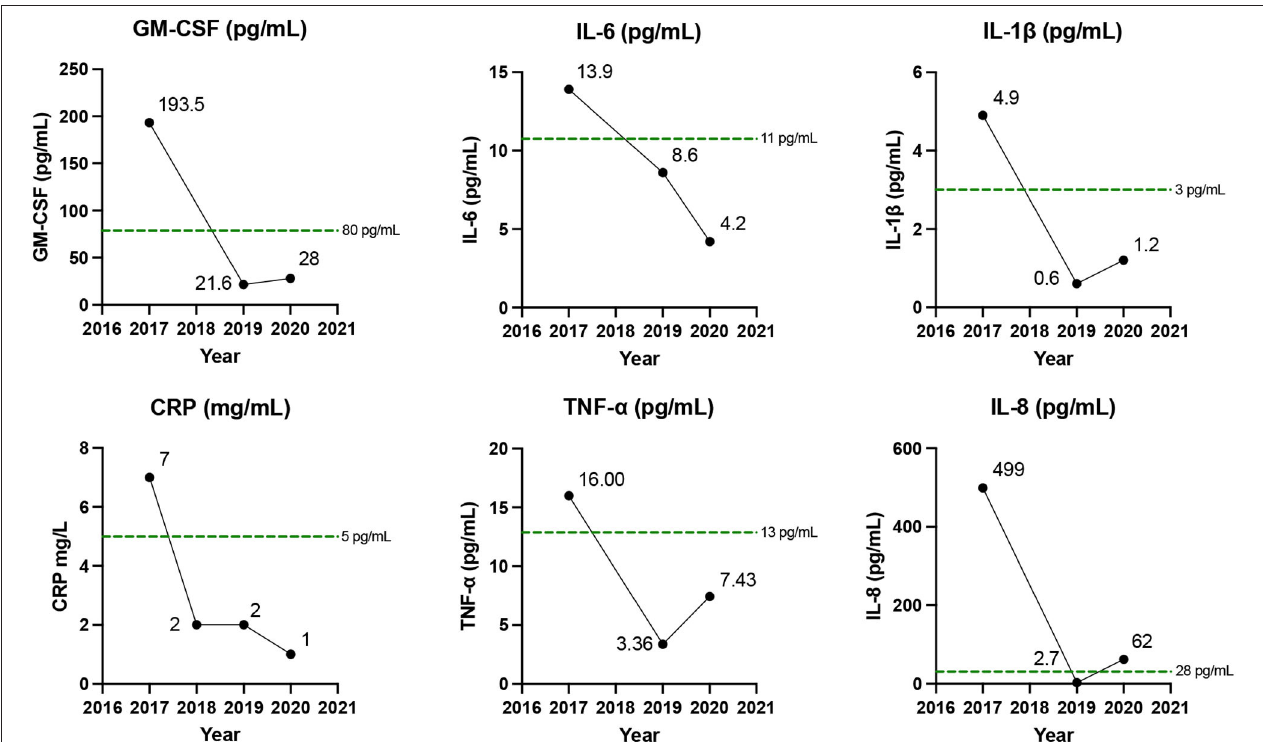
FIGURE 1 | Inflammatory biomarkers. Data represent C.A.’s inflammatory biomarkers prior to starting a ketogenic diet and at two time points, 2019 and 2020, after commencing the diet. Green dotted line represent the threshold of normal range for each biomarker. All markers improved on a ketogenic